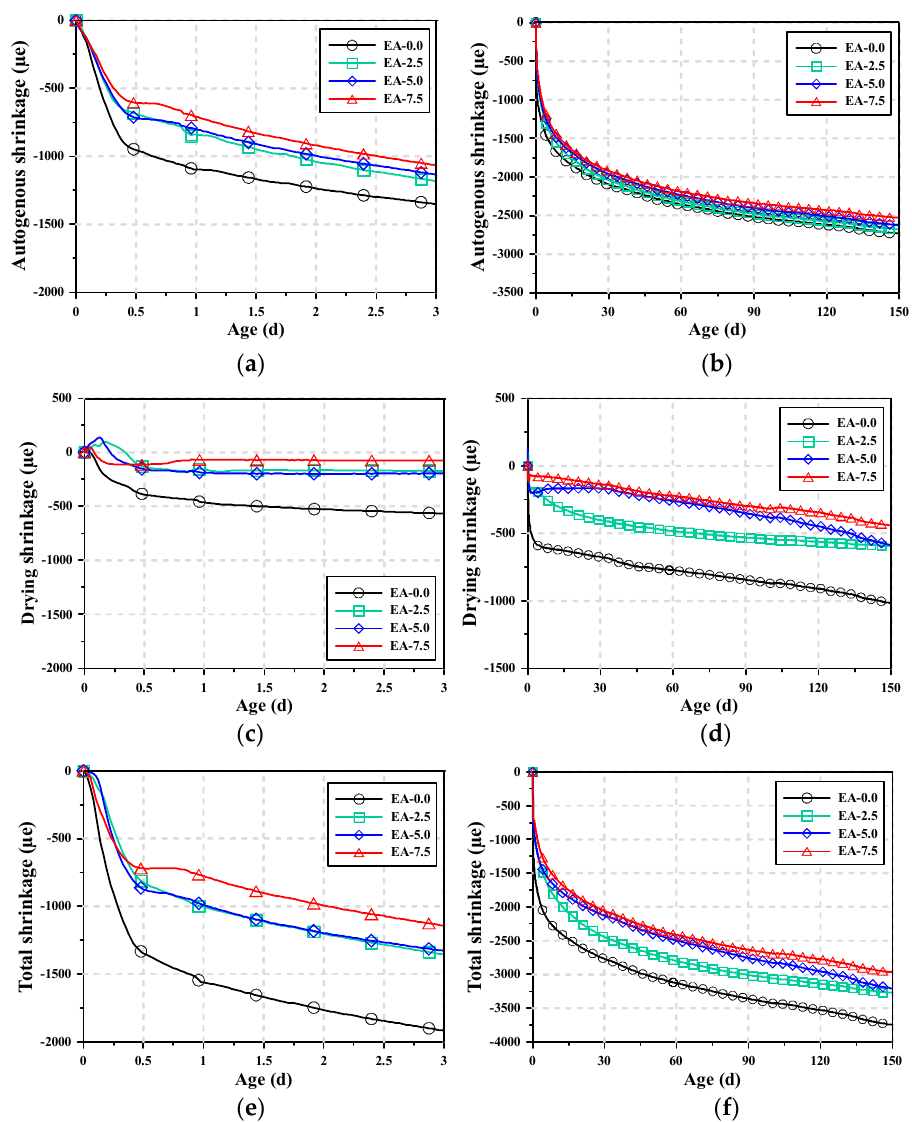
Figure 3. Autogenous shrinkage curves of AAM mortars: ( a ) autogenous shrinkage for 3 d, ( b ) autogenous shrinkage for 150 d, ( c ) drying shrinkage for 3 d, ( d ) drying shrinkage for 150 d, ( e ) total shrinkage for 3 d, and ( f ) total shrinkage for 150 d.